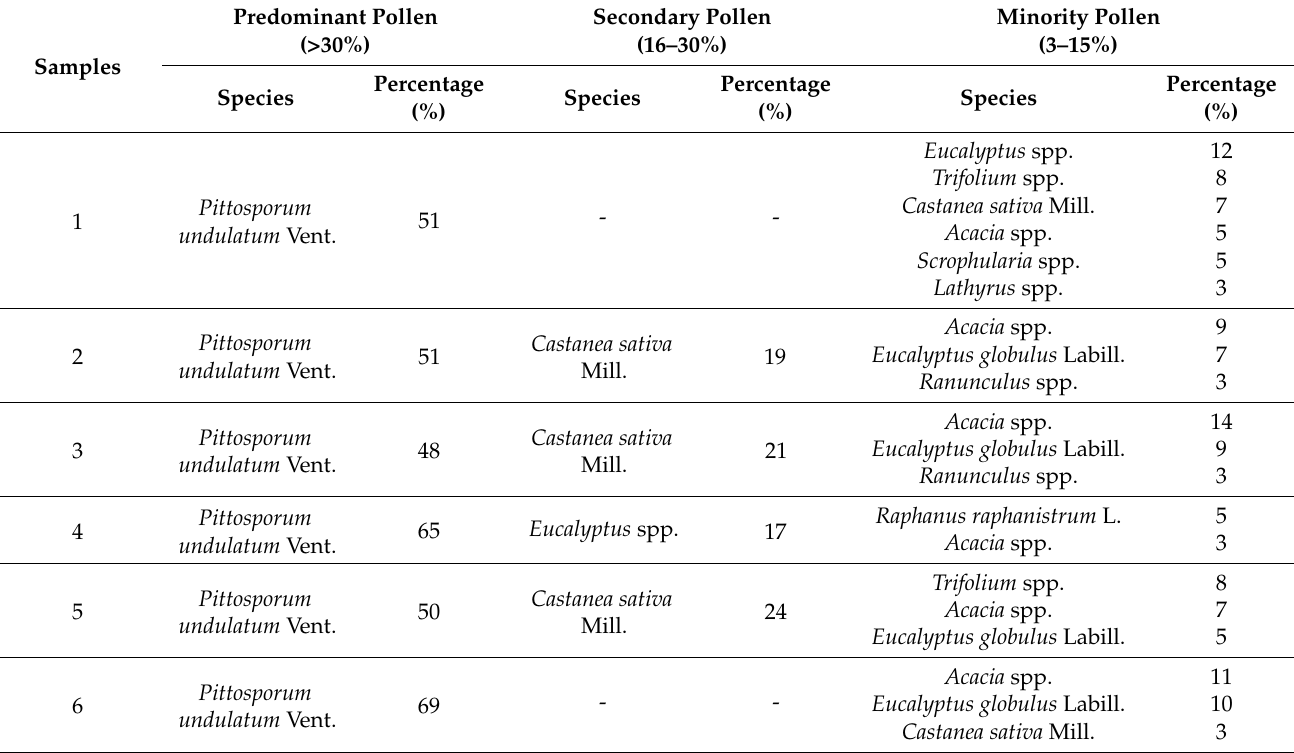
Table 1. Pollen spectrum of types of honey studied. Data presented are about predominant, secondary, and minority pollen percentages per